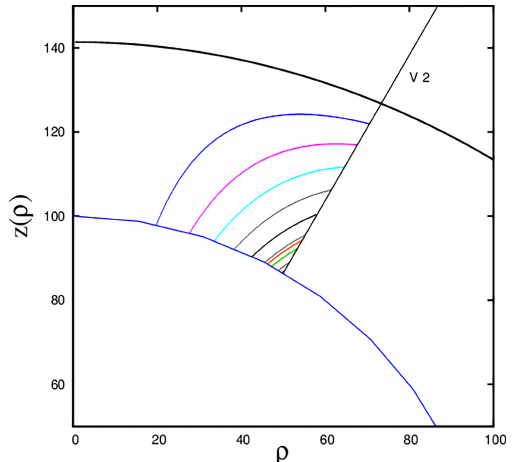
Figure 2. Some streamlines originating at different points at the termination shock are shown with different colors. The Voyager 2 trajectory is the black straight line crossing the various streamlines on which the solar wind has evolved differently (Fahr et al., 2016).